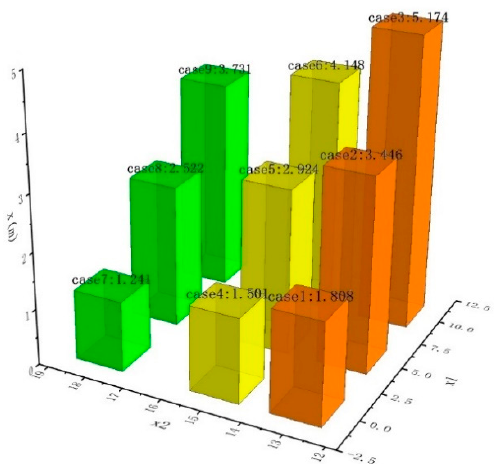
Figure 17. Vehicle centroid X -axis coordinates at the end of the water-exit process of 9 cases.